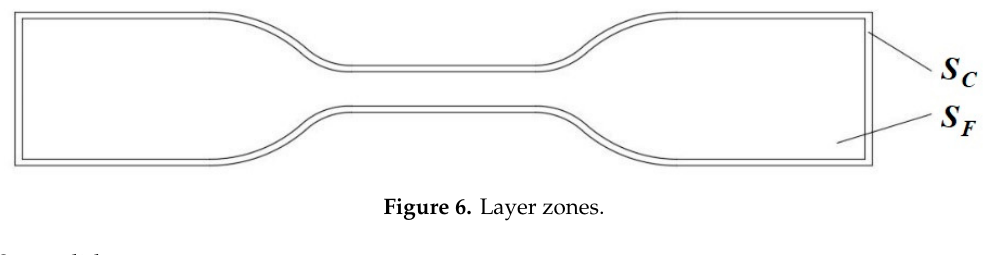
Figure 6. Layer Figure 6. Layer zones.